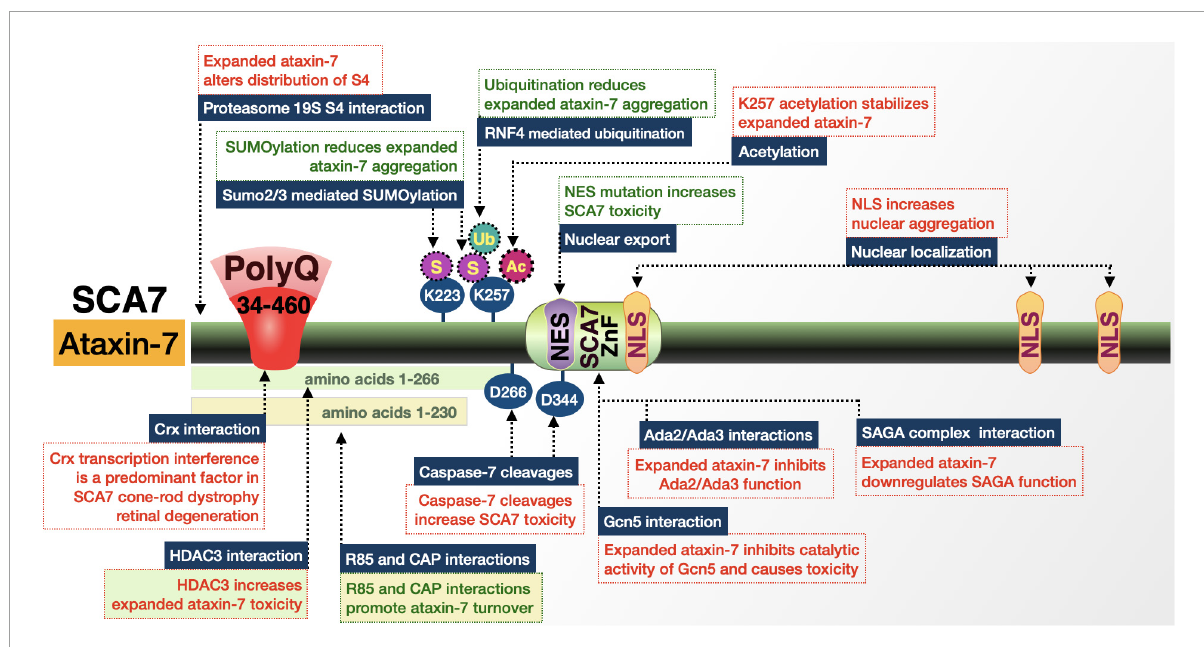
FIGURE9 Graphic representation of the SCA7 protein, its domains, interactions, and modifications. Details are in the main